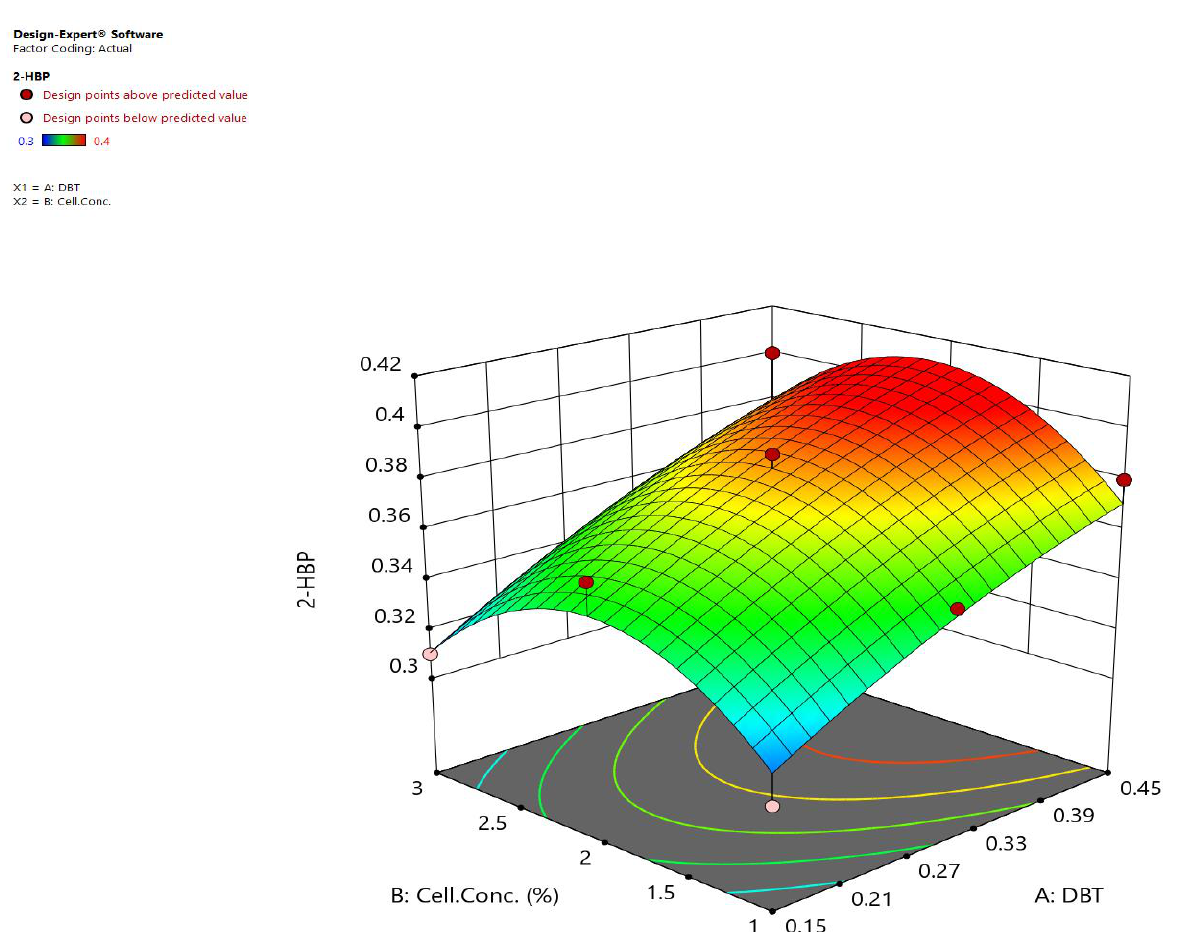
Table 5. ANOVA for evaluation of R 1 for Rhodococcus erythropolis IGTS8 in the presence of the nanostructure.